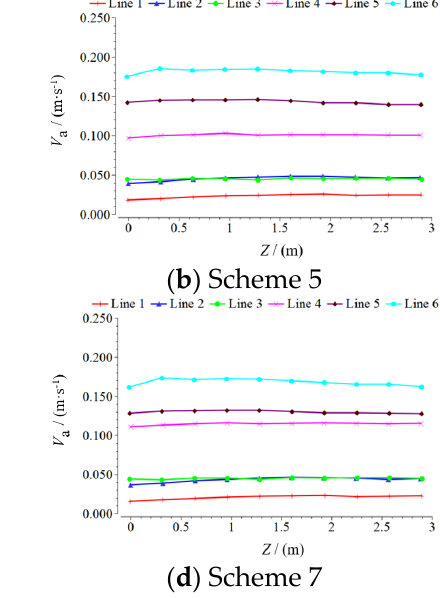
Figure 16. Diagram of axial velocity on the inlet of the sump 4#.